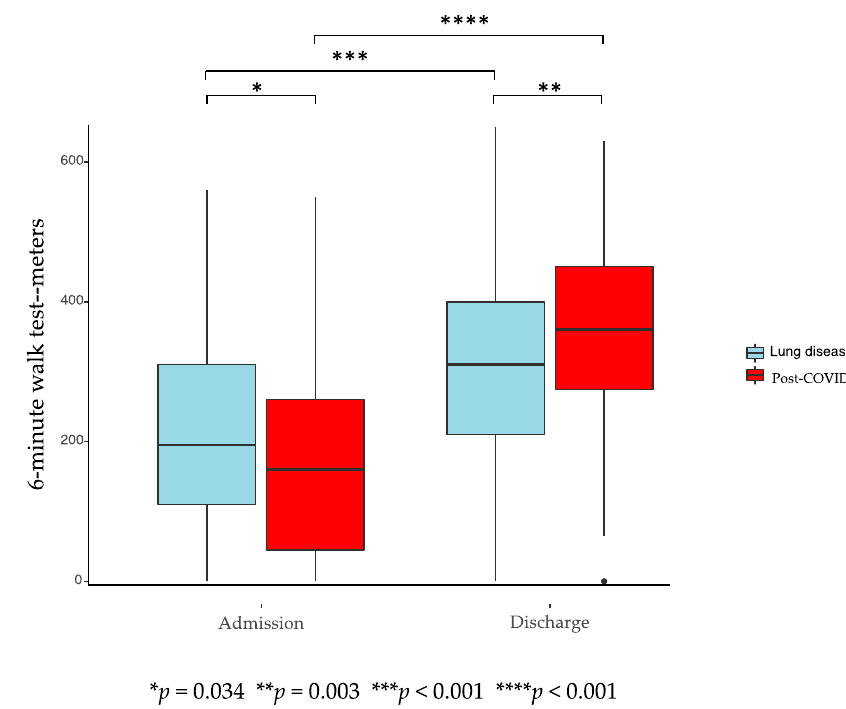
Figure 1. 6-min walk test of post-COVID-19 Group and lung diseases group.